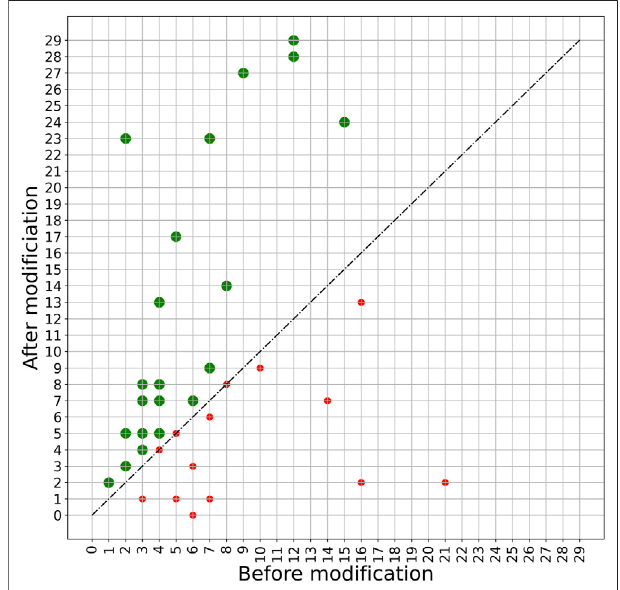
FIGURE 9 | Impact of applying model B with a 1000-nucleotide seed on phage sequences. The model is trained based on the genome sequence of three phages with IDs 5294, 5317, and 5291 with a seed length of 1000. The trained model is then used to modify the genome sequence of all 42 phages under study.Theplotshowsthehostrangeofthesephagesbeforeandaftermodi fi cation. Thegreenspotsshowphageswhosehostrangeisimprovedaftermodi fi cation.The host ranges of 26 phages are improved after modifying with this